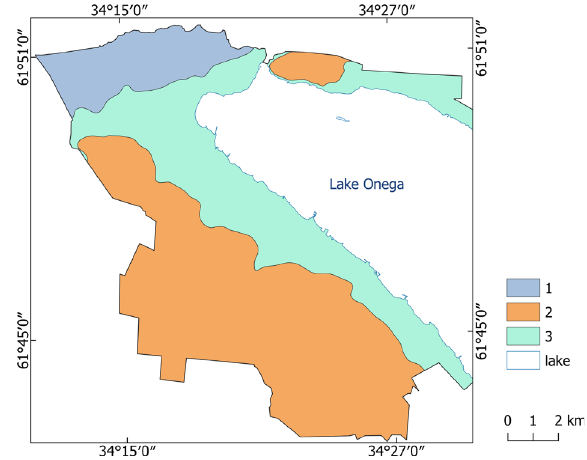
Fig. 9. Scheme of distribution of quaternary deposits 1 – loamy-clayey lacustrine-glacial deposits; 2 – moraine sandy loam; and 3 – sandy lacustrine-glacial and lacus - trine